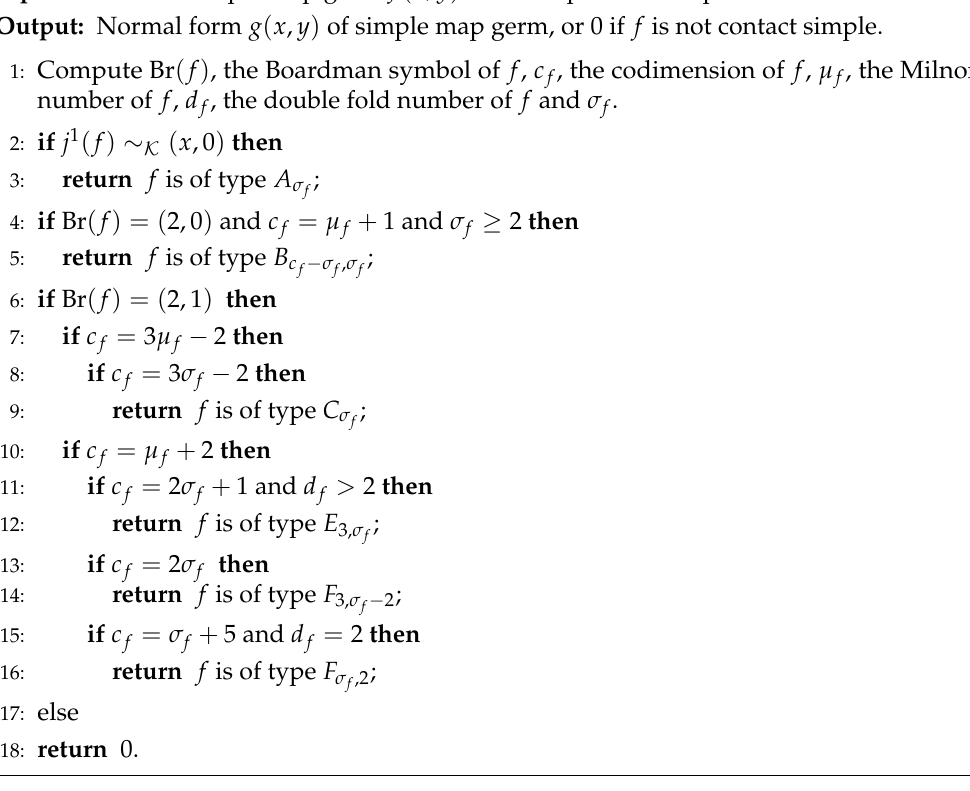
Algorithm 5 Contact simple plane to plane maps